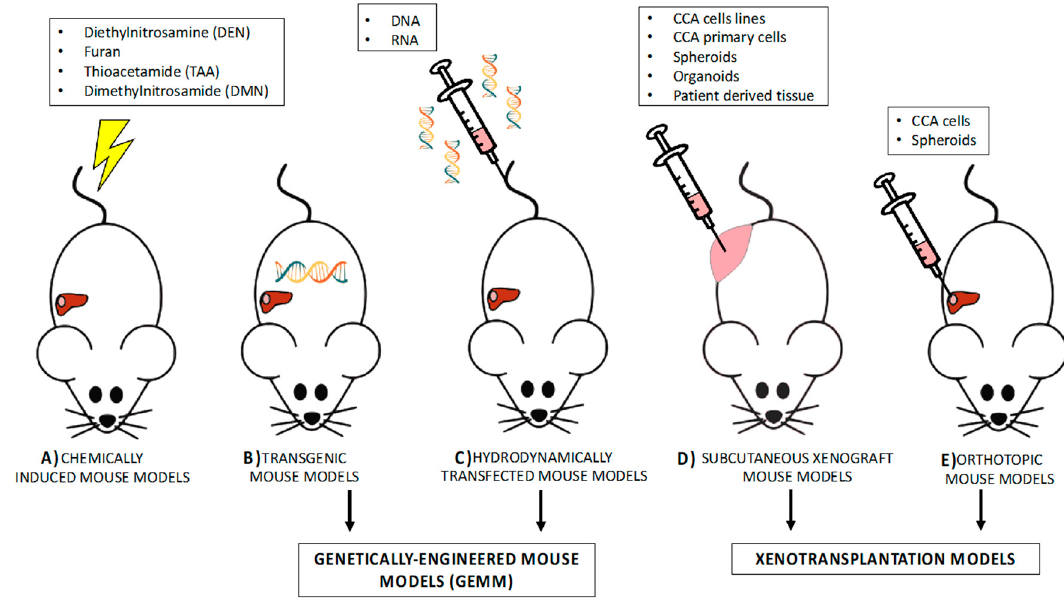
Figure 2. Mouse models of CCA. ( A ) Chemical carcinogens (DEN, furan, TAA, and DMN) administered to mice are able to induce CCA tumorigenesis. ( B ) Transgenic models are animals whose genome has been modified by introducing oncogenic sequences responsible for CAA induction. ( C ) Hydrodynamic transfection is used for delivering DNA or RNA into the tail vein and is considered to be an alternative for CCA germ-line knockout or CCA transgenic mice. ( B , C ) are included in the genetically-engineered mouse models (GEMM). ( D ) Xenografts are models of a heterotopic graft, which involve the ectopic (subcutaneous) injection of CCA human cells, spheroids, organoids, or patient-derived tissue in immunodeficient or nude mice. ( E ) Orthotopic xenograft models accurately recapitulate the TME, since CCA cells or spheroids are directly injected into mouse portal or splenic veins, or into liver parenchyma. ( D , E ) are of xenotransplantation models.